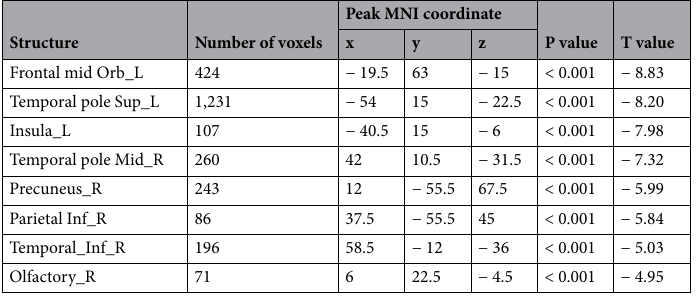
Table 3. Areas of decreased GM volume (p < 0.001) in Meige syndrome patients and control subjects.